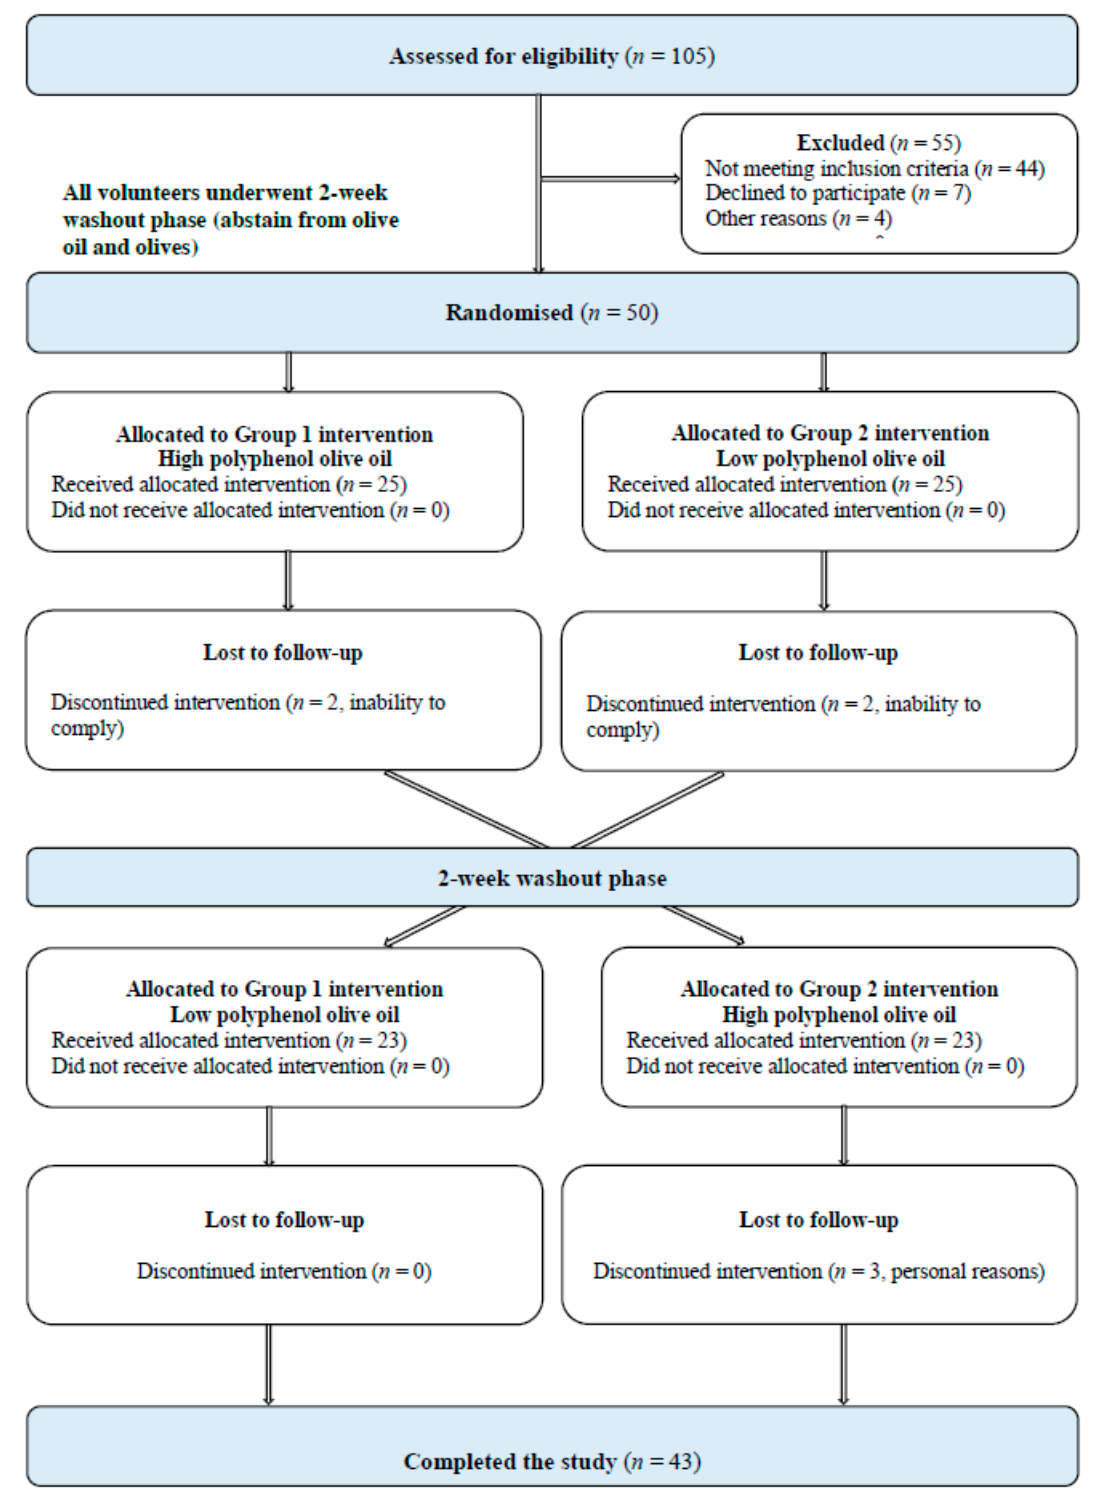
Figure 1. Study participant flow diagram.